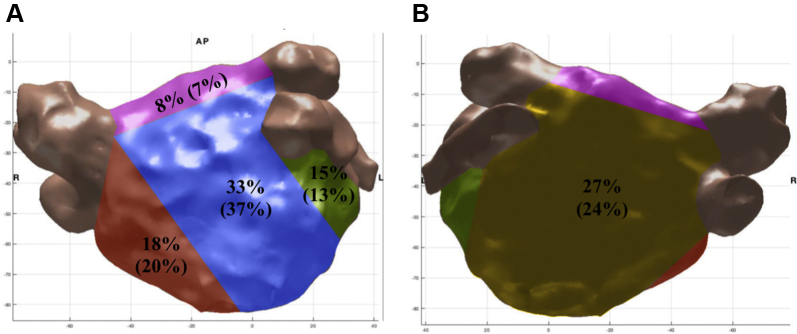
Anterior (A) and posterior (B) views of the left atrium showing the distribution of the low-voltage zones and rate-dependent conduction velocity slowing sites (percentage in brackets) in the patients involved in the study. Red indicates septum; green indicates lateral; blue indicates anterior; yellow indicates posterior; purple indicates roof.